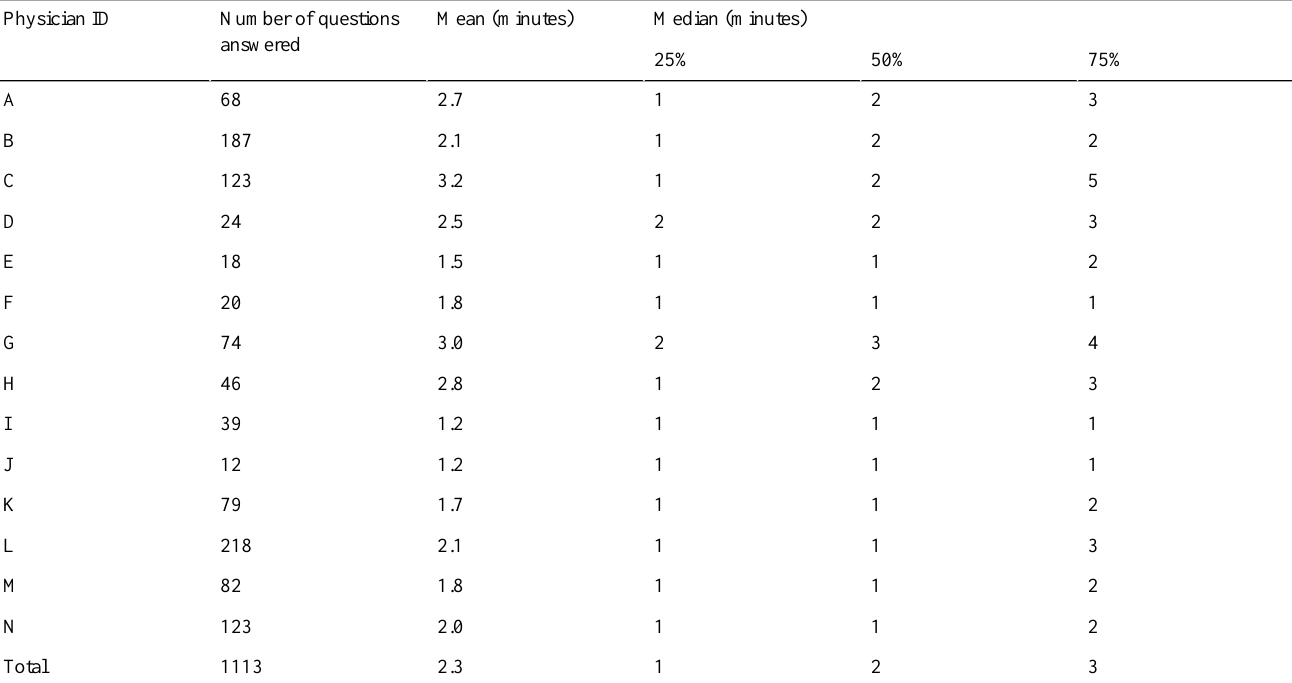
Table 2. Response time of participating physicians